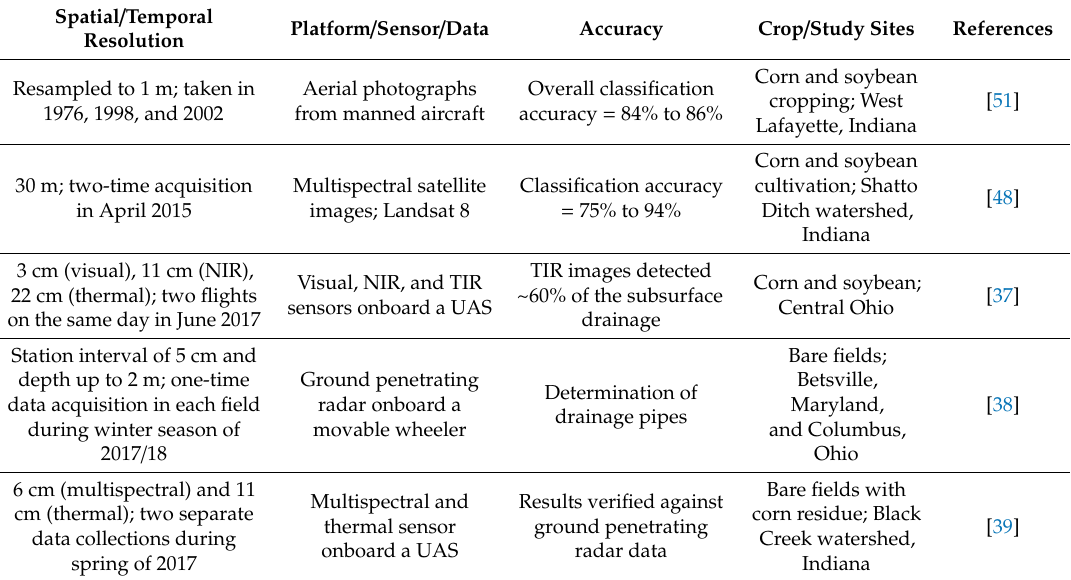
Table 2. Subsurface tile drain mapping using RS data from multiple